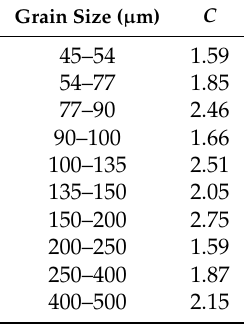
Table 1. Constant C from Dong et al. [24] that relates threshold shear velocity and moisture content according to the mean grain size.